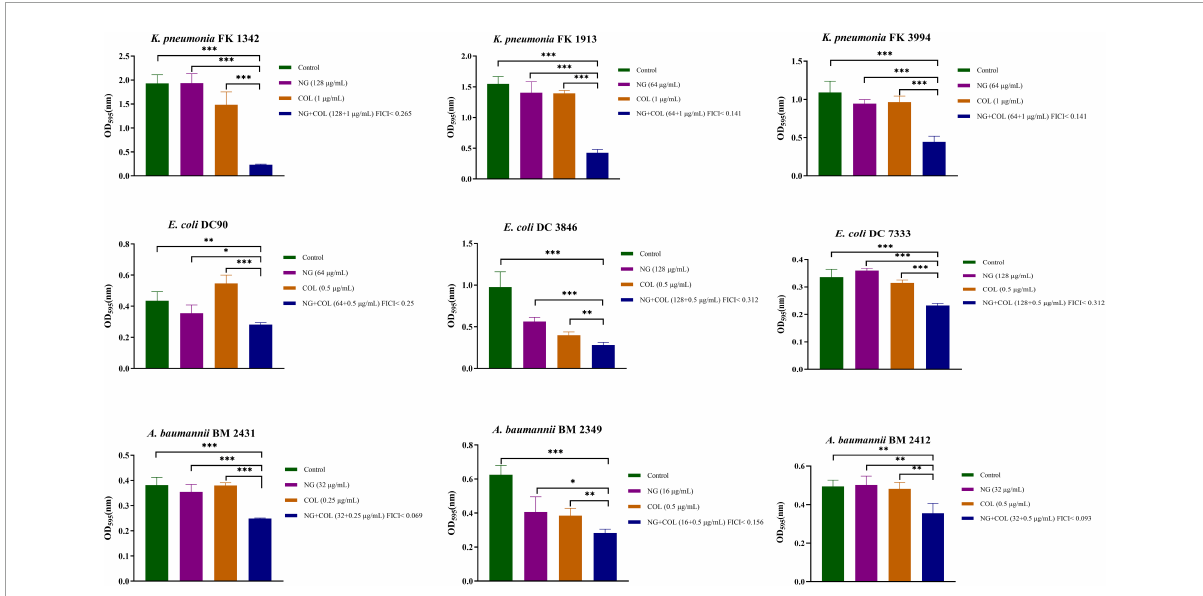
FIGURE3 Biofilm inhibitory effects of colistin combined with naringenin on colistin-resistant Klebsiella pneumonia , colistin-resistant Escherichia coli , and colistin-resistant Acinetobacter baumannii . Drug concentration was chosen from the checkerboard method with FICI < 0.5. * P < 0.05, ** P < 0.01, and *** P < 0.001 analyzed by Student’s t -test. Naringenin (NG) and colistin (COL).